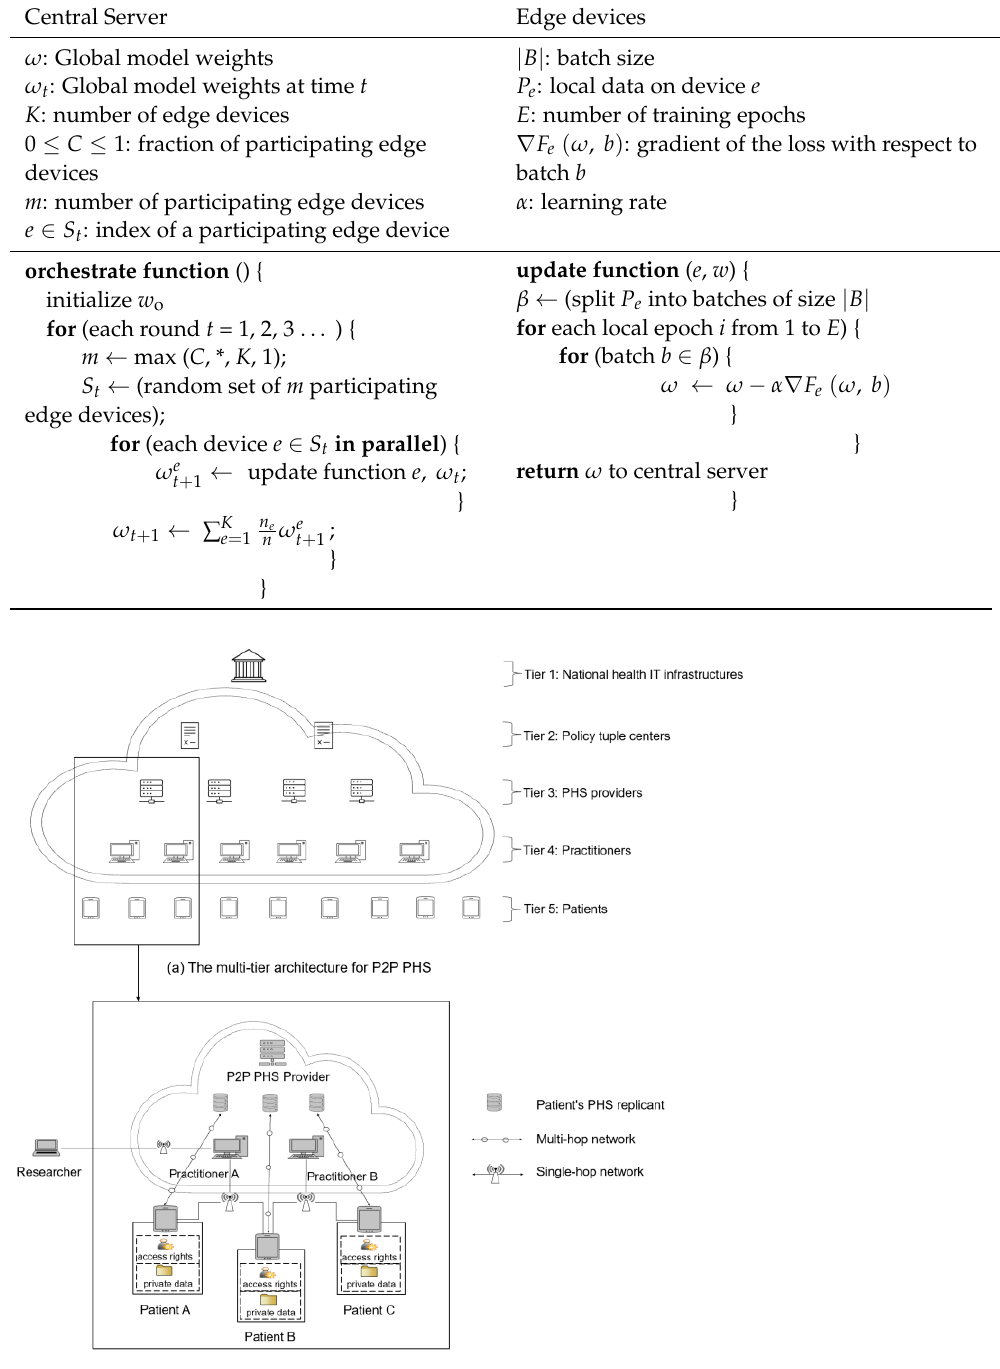
Algorithm 1 FL Algorithm with a central server—FedAvg